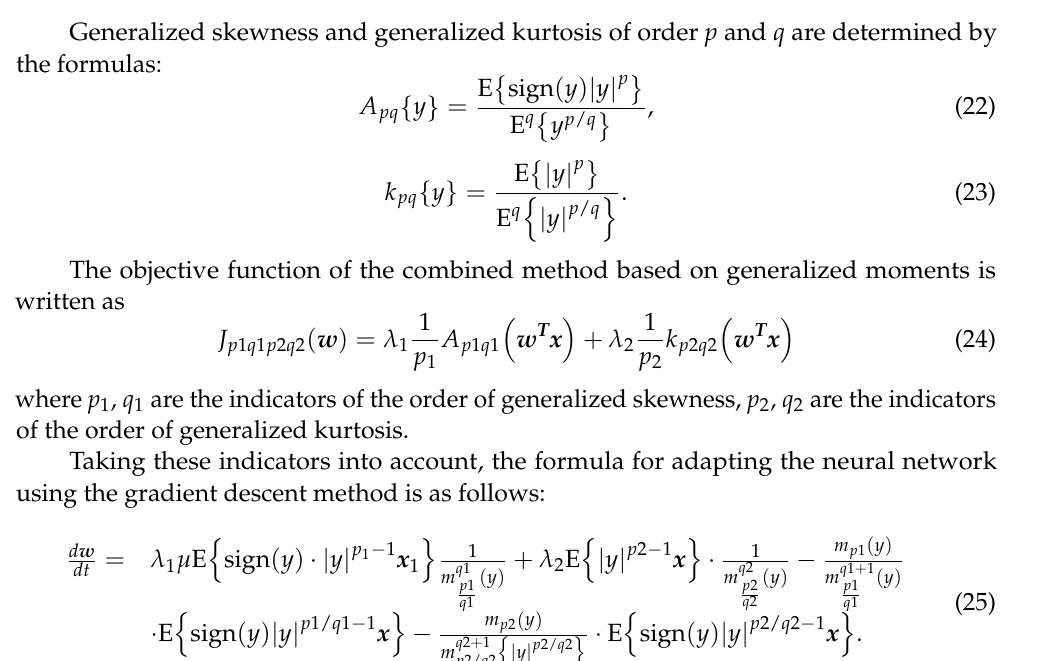
Figure 4. Dependence of root-mean-square error of kurtosis on the volume of sample.